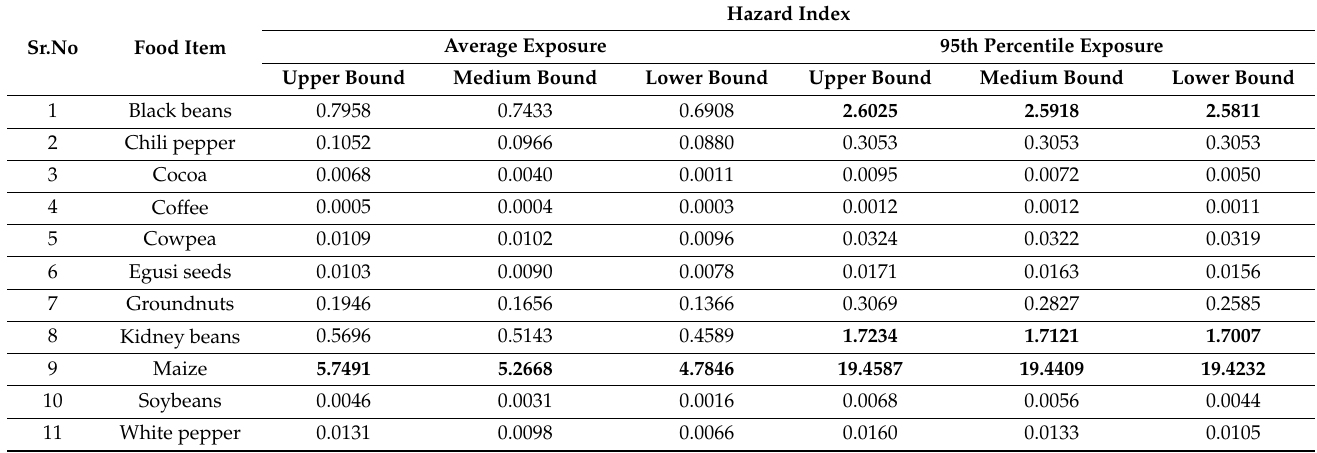
Table 2. Hazard index values representing chronic health risk of cumulative pesticides in 11 food items from the 3 largest cities of